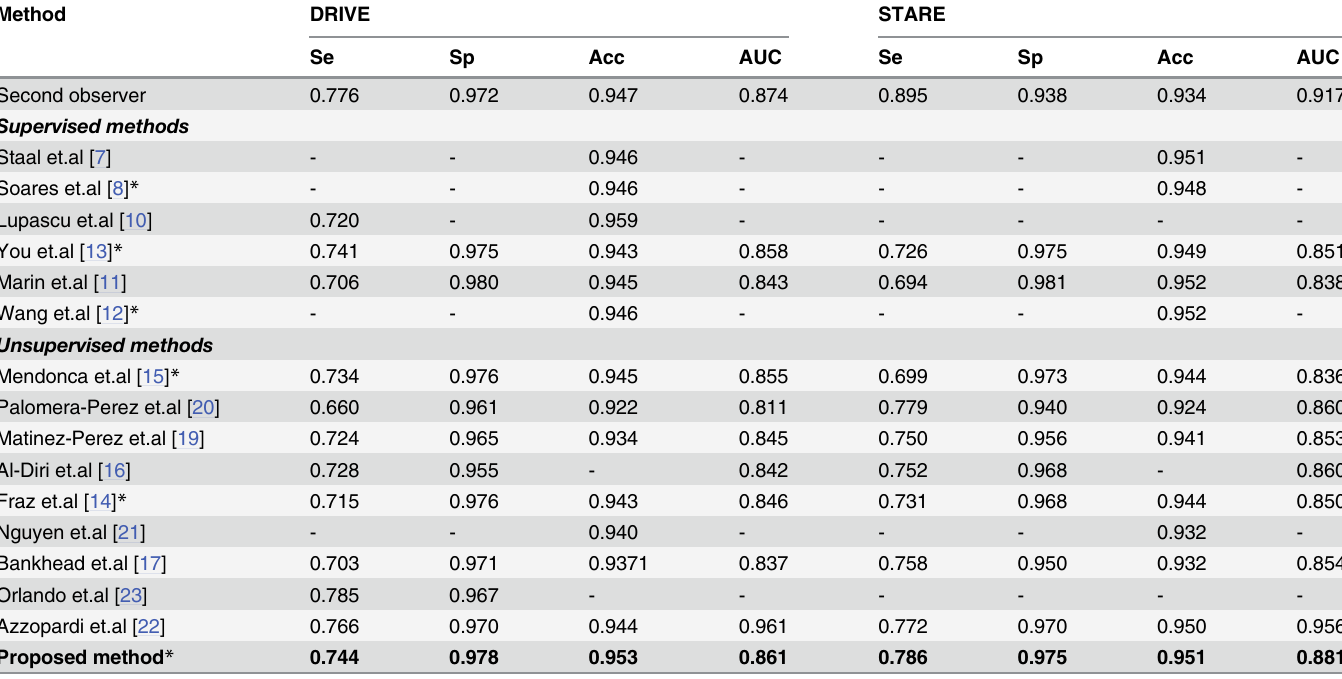
Table 6. Performance of different segmentation methods, in terms of sensitivity ( Se ), specificity ( Sp ), accuracy ( Acc ) area under the curve ( AUC ), on the DRIVE and STARE datasets.